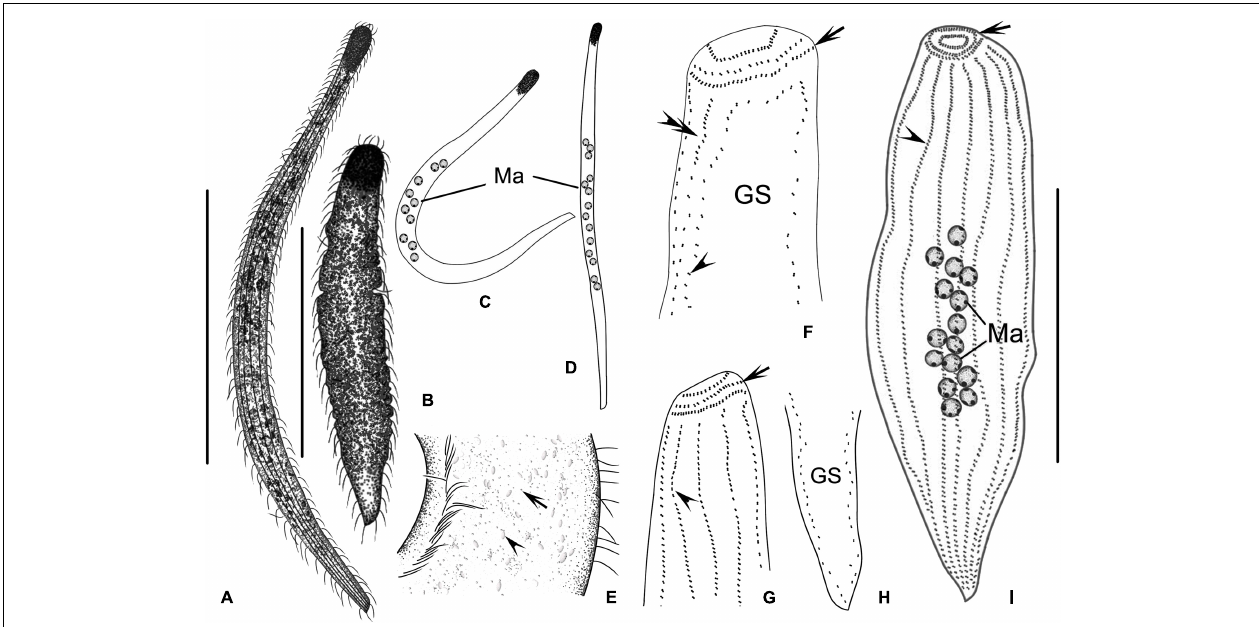
FIGURE 2 | (A–I) Paratrachelocerca typica gen. nov., spec. nov. in vivo (A–E) and after protargol staining (F–I) . (A) Typical individual. (B) An extremely contracted cell. (C–D) Different body shapes. (E) Distribution of cortical granules in glabrous stripe (arrow). Arrowhead points to the granules. (F,G) Detailed ciliature of left (F) and right (G) side of anterior body region, showing three circumoral kineties each composed of a row of dikinetids (arrow), glabrous stripe, somatic kineties (double arrowheads in F and arrowhead in G ) and bristle kinety (arrowhead in F ). (H) Ciliary pattern of tail region showing glabrous stripe. (I) Overview showing ciliary pattern and multiple macronuclei of holotype specimen, three circumoral kineties each composed of a row of dikinetids (arrow) and somatic kineties (arrowhead). GS, glabrous stripe; Ma, macronuclei. Scale bars = 300 µ m (A,B) ; 80 µ m (I) .